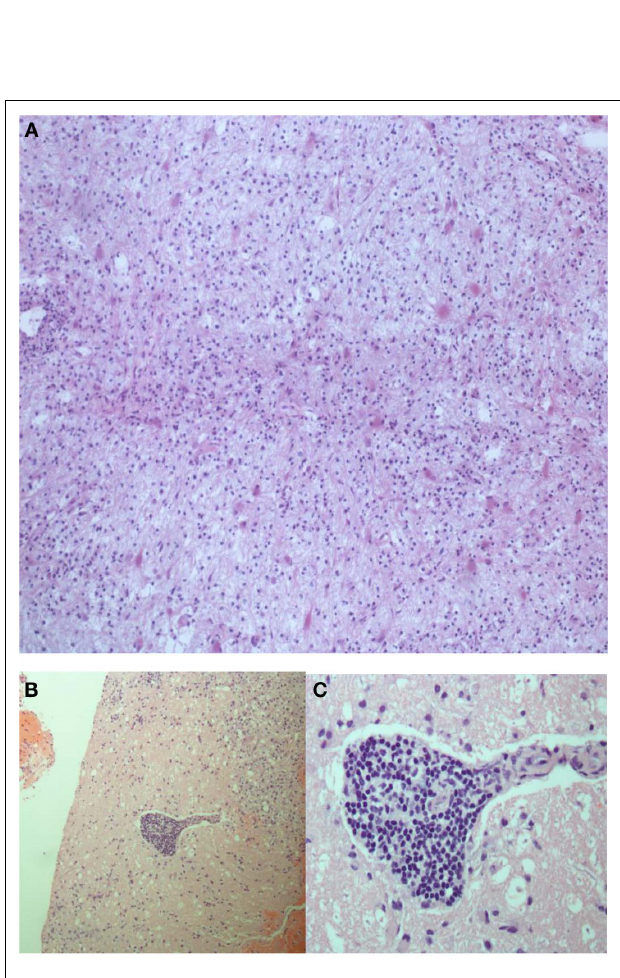
FIGURE 5 | Glial fibrillary acidic protein staining shows relative a reactive gliosis